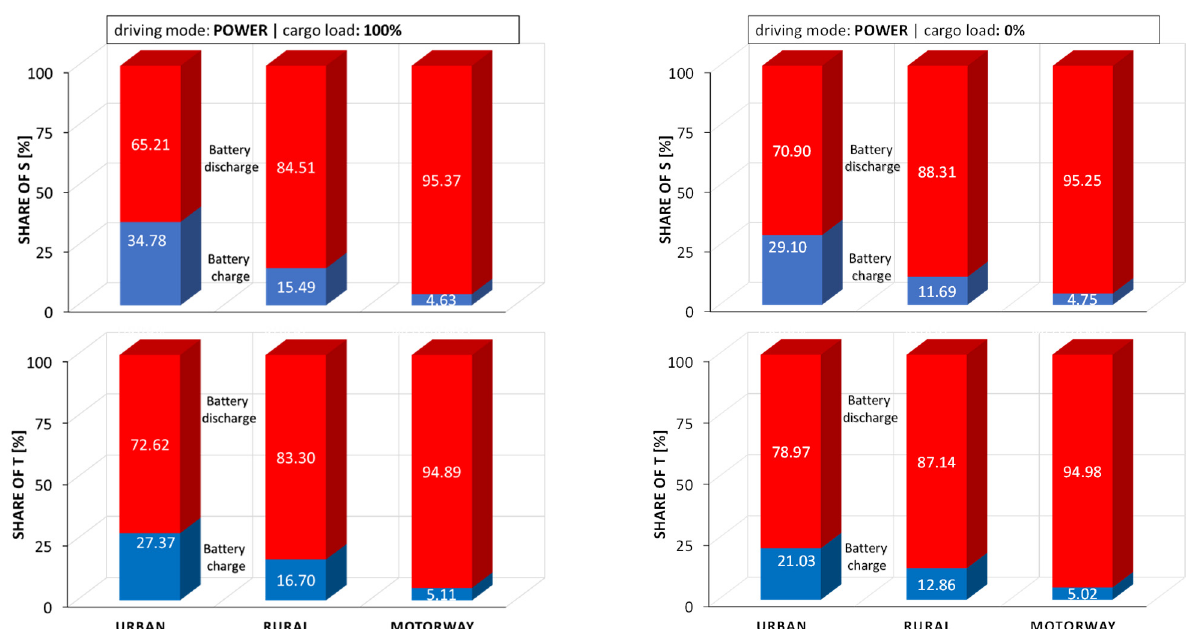
Figure 18. Parameterization of time- and route-dependent energy consumption and recovery for individual phases of the RDC test.